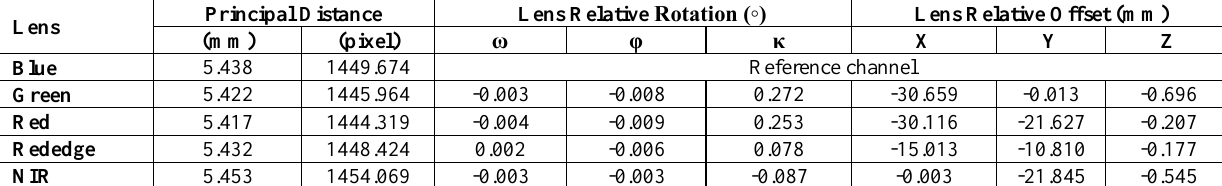
Table 3: Calibrated parameters obtained using the CRP